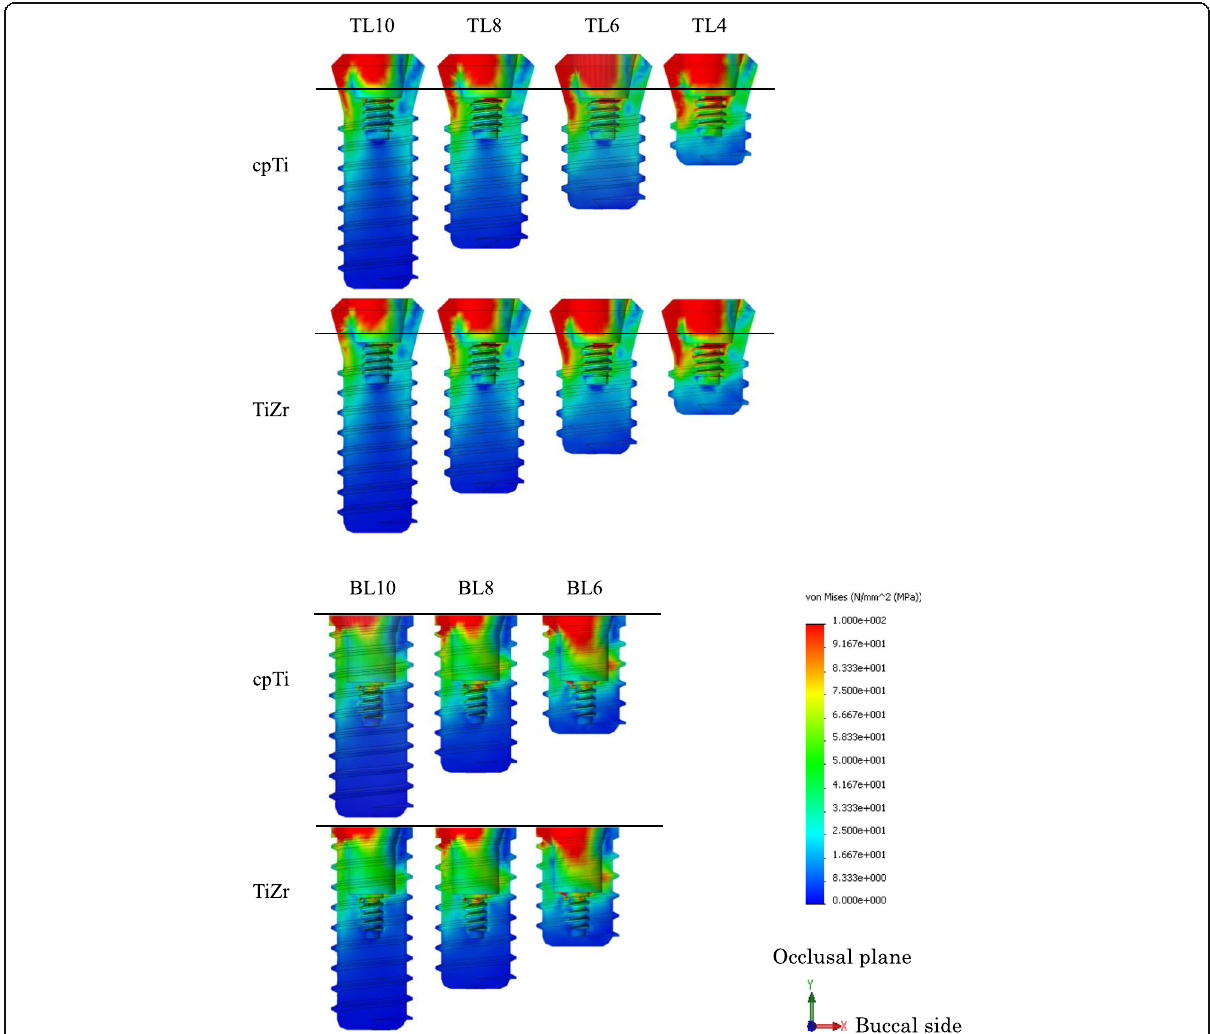
Fig. 7 Von Mises stress distribution in implant bodies. ( right : buccal side, left : lingual